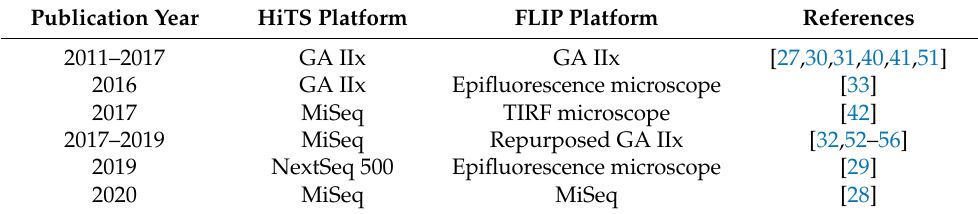
Table 2. Evolution of the hardware used for HiTS–FLIP.